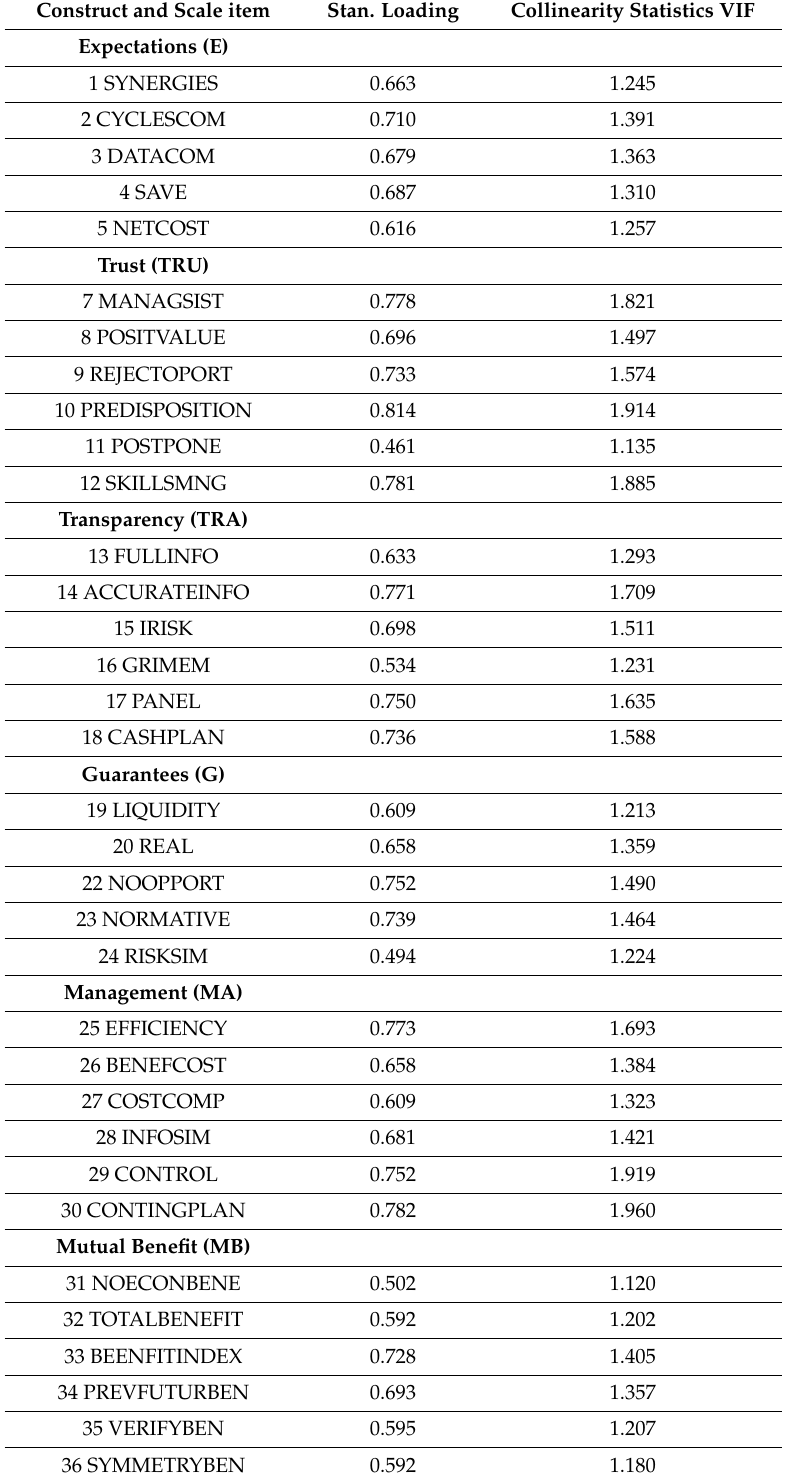
Table 2. Results of the multicollinearity